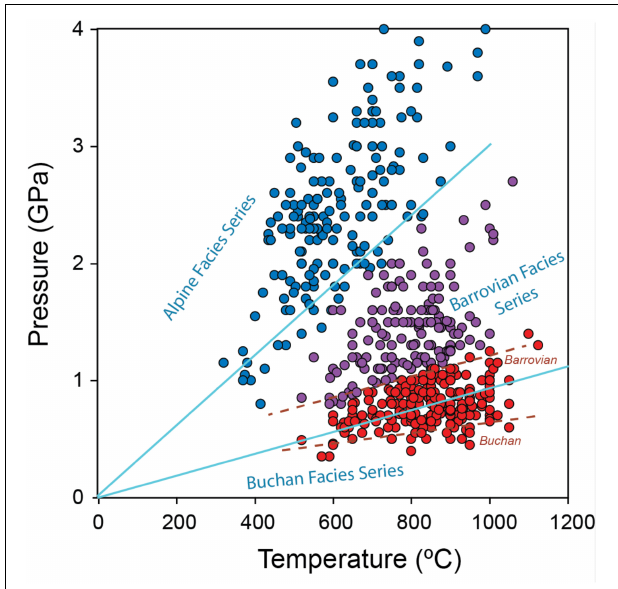
FIGURE 3 | Variations in the temperatures and pressures from the peak of metamorphism estimates from Brown (2006, 2007), as in Brown and Johnson (2019), The facies series are from Zheng and Zhao